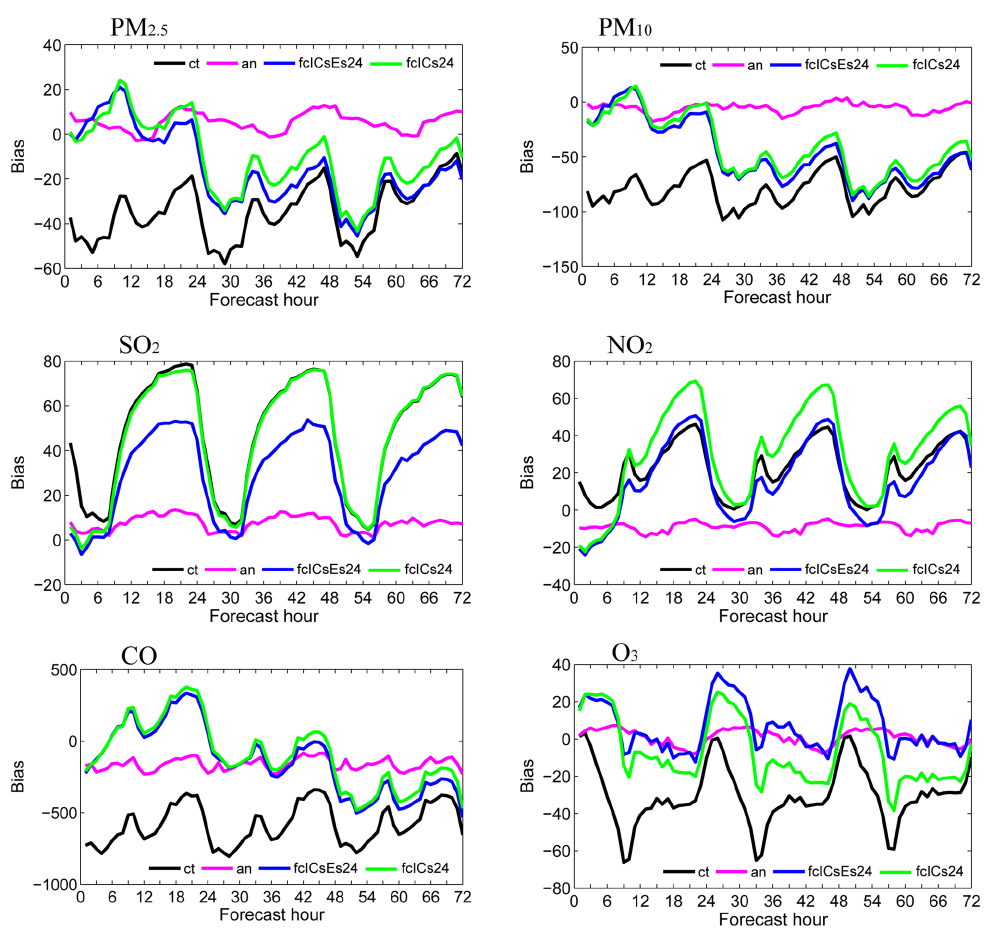
Figure 5. Bias of surface PM 2 . 5 , PM 10 , SO 2 , NO 2 , CO, and O 3 as a function of forecast range calculated against all the independent observations over the Beijing–Tianjin–Hebei region shown in Fig. 1. The 72h forecasts were performed at each 00:00UTC from 6 to 14 October 2014, and the statistics were computed from 6 to 14 October. Units: µgm − 3